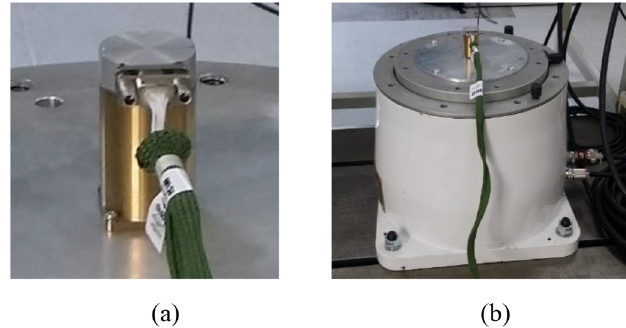
Fig. 7. (a) Prototype of the MHD angular vibration sensor; (b) Prototype on Angular